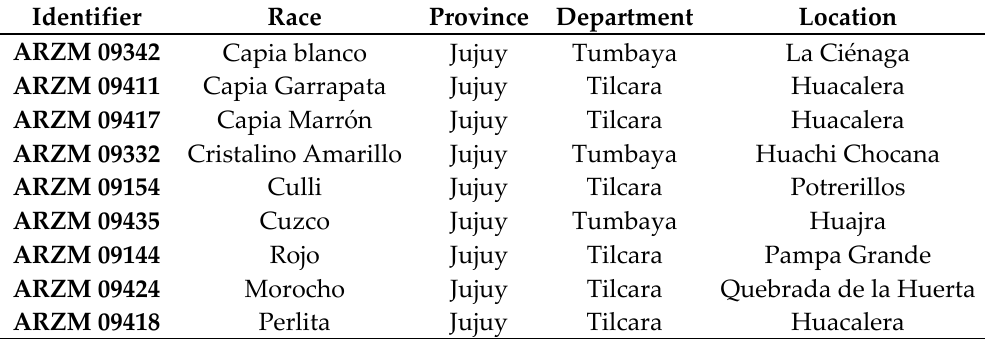
Table 1. Origin and identification of plant